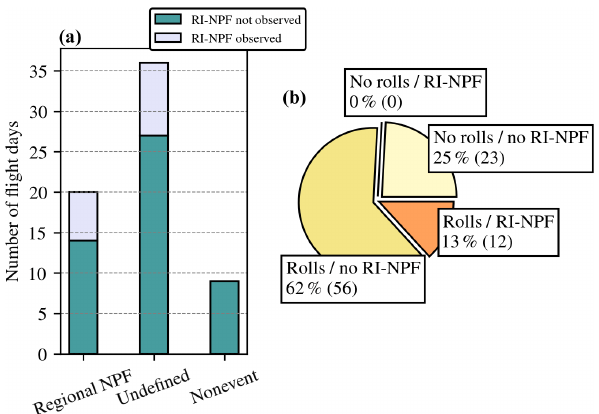
Figure 10. Panel (a) shows how the roll-induced NPF (RI-NPF) observations distribute into different NPF event classes on the flight days. Panel (b) shows the classification of each measurement flight into four different classes based on whether rolls and/or RI-NPF over the same area were observed or not. Note that the data in (a) consist of flight days, while the data in (b) consist of individual flights (there could be more than one flight per day).